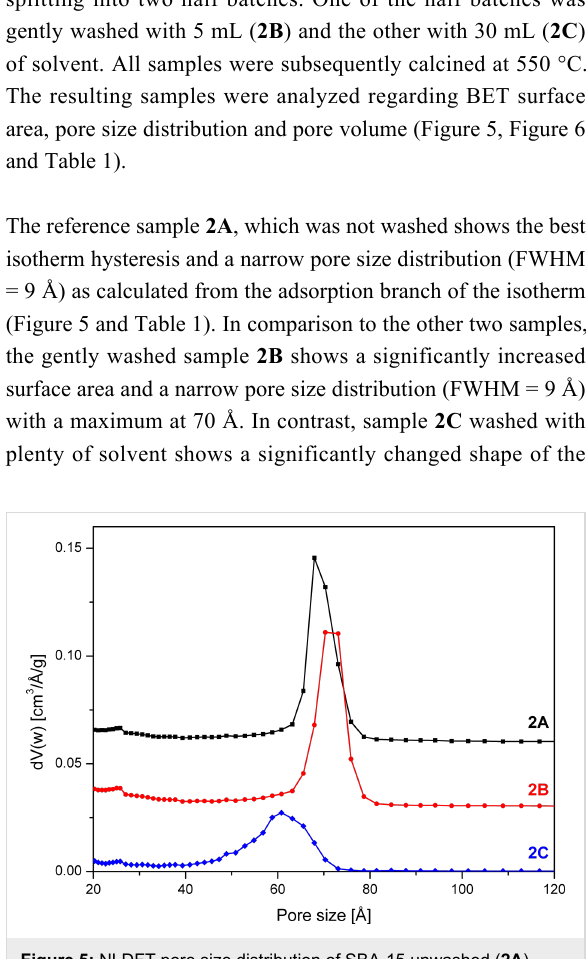
splitting into two half batches. One of the half batches was gently washed with 5 mL ( 2B ) and the other with 30 mL ( 2C ) of solvent. All samples were subsequently calcined at 550 °C.